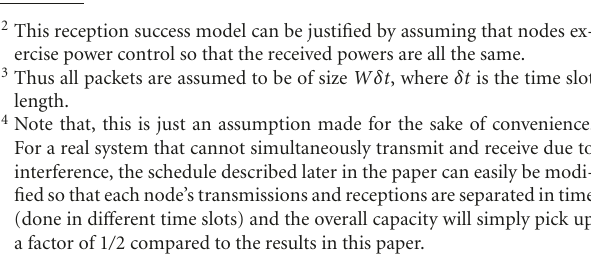
√ (cid:2) / n , where l